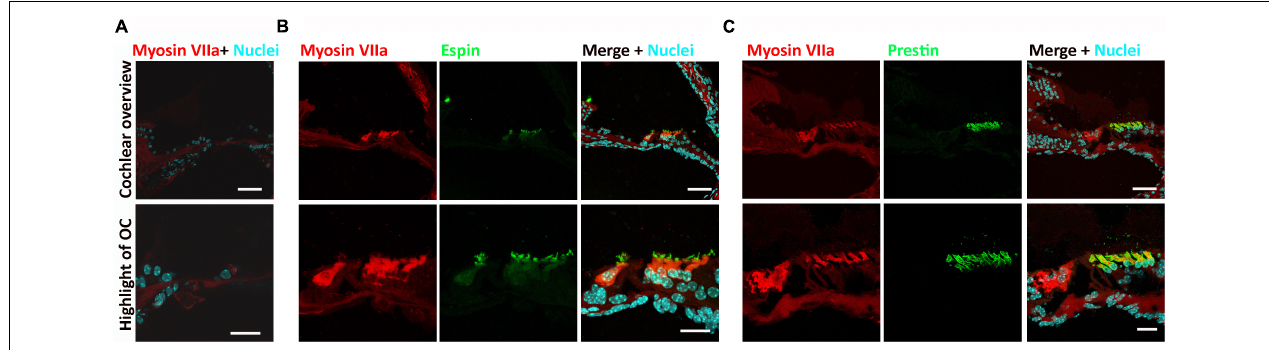
FIGURE 1 | Expression of espin and prestin was observed in the 5-azacytidine (5-aza)-treated mouse inner ear. (A) No hair cell was observed in the cochlear sections of the vehicle-treated mice. (B) Expression of espin was observed in the hair bundles of myosin VIIa-expressing regenerated hair cells in the 5-aza-treated mice. (C) Prestin expressed in the myosin VIIa-expressing outer hair cells in the cochlear sections of the 5-aza group mouse. All the figures were from the apical cochlear turn. OC, organ of Corti. Scale bar: 50 µ m in cochlear overview and 20 µ m in OC highlight.